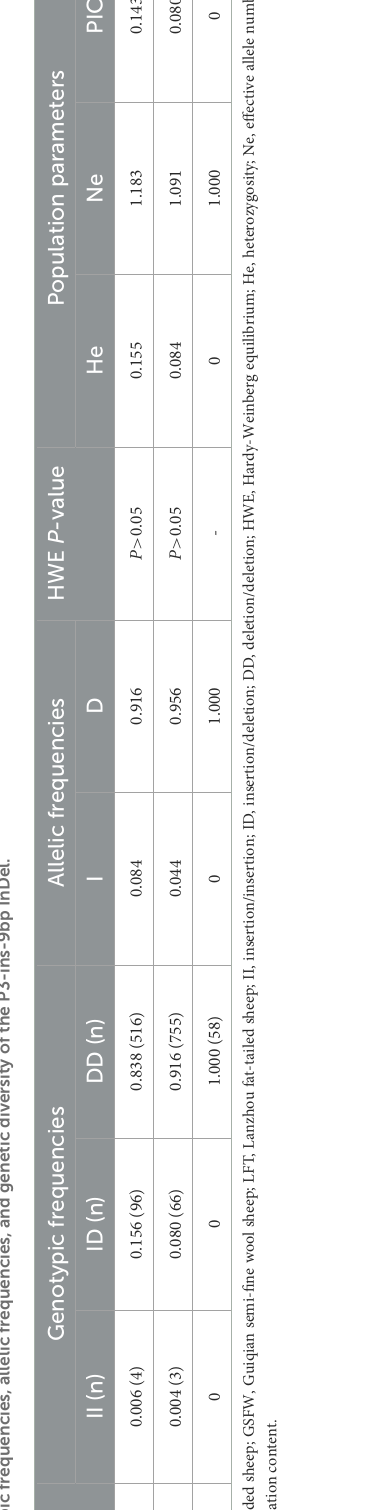
(Table 4). For LXBH sheep, t-tests results confirmed that the P3-ins-9bp InDel had no remarkable influence on growth traits for lambs ( P > 0.05) (not shown). Yearling rams with the homozygous DD genotype were found to have lower chest depth, body weight, cannon circumference, and body height ( P < 0.05). Yearling ewes with the homozygous